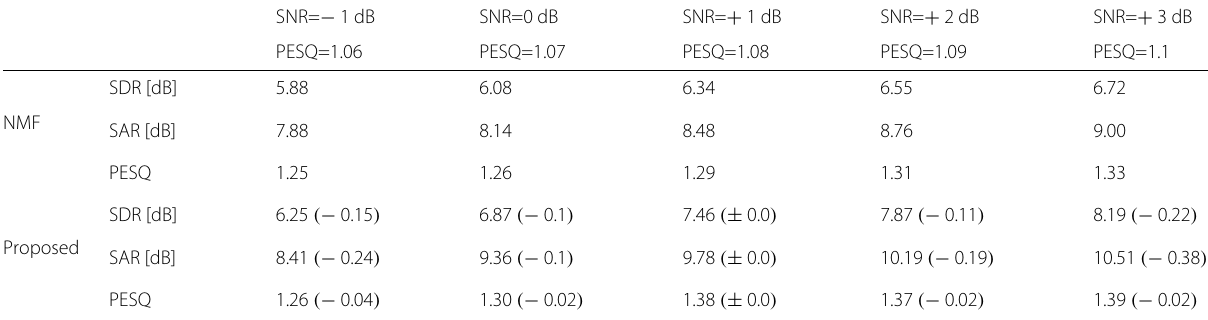
Table 5 Performance degradation of proposed method for suboptimal parameter settings. We chose λ T = 0.5 = const. and λ = 8.0 = const. which are optimal for SNR = 1 dB and evaluated SNRs − 1 dB, . . . , 3 dB. For each performance value of the proposed E method, the degradation relative to optimum parameter settings for λ E and λ T is given in parentheses. For this experiment, ego-noise by movements of Sequence III is